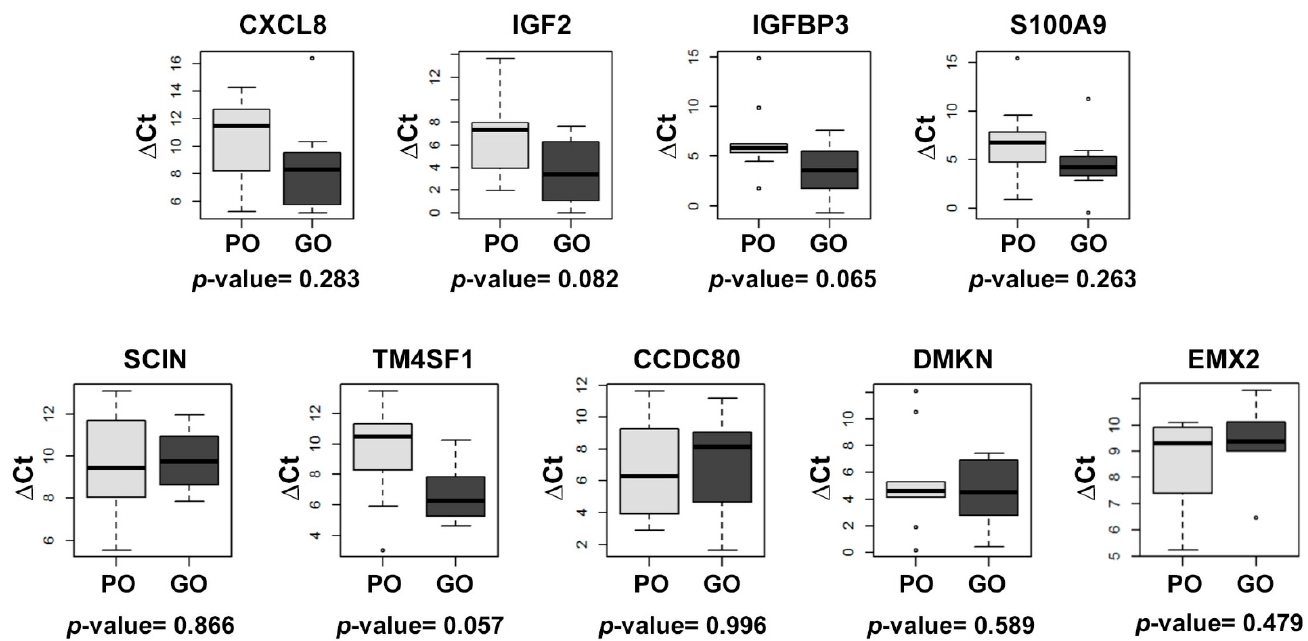
Figure 2. Box plots depicting the qRT-PCR relative expression of the genes differentially expressed in patients with good versus poor outcome to vinflunine treatment. β -actin (ACTB) was used as the endogenous gene. CXorf57 expression was not detected by qRT-PCR. ∆ Ct: ( ∆ Ct = Ct [gene] − Ct [endogenous]); PO: poor outcome; GO: good outcome.